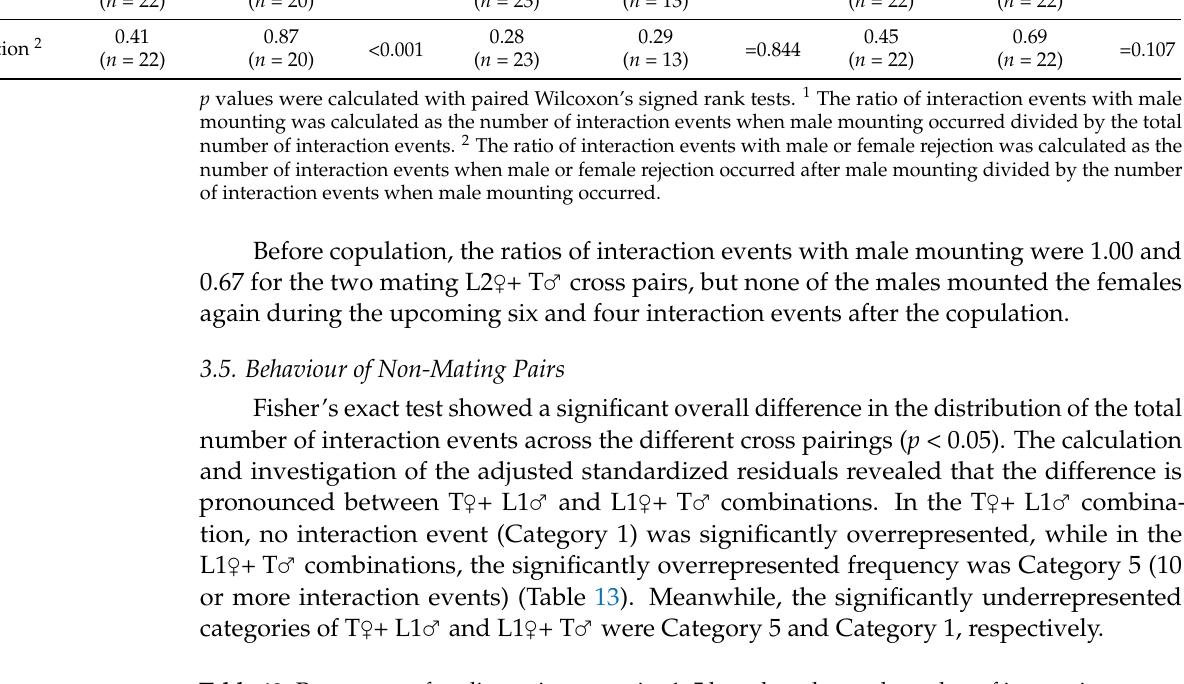
Table 13. Percentage of replicates in categories 1–5 based on the total number of interaction events and the adjusted standardized